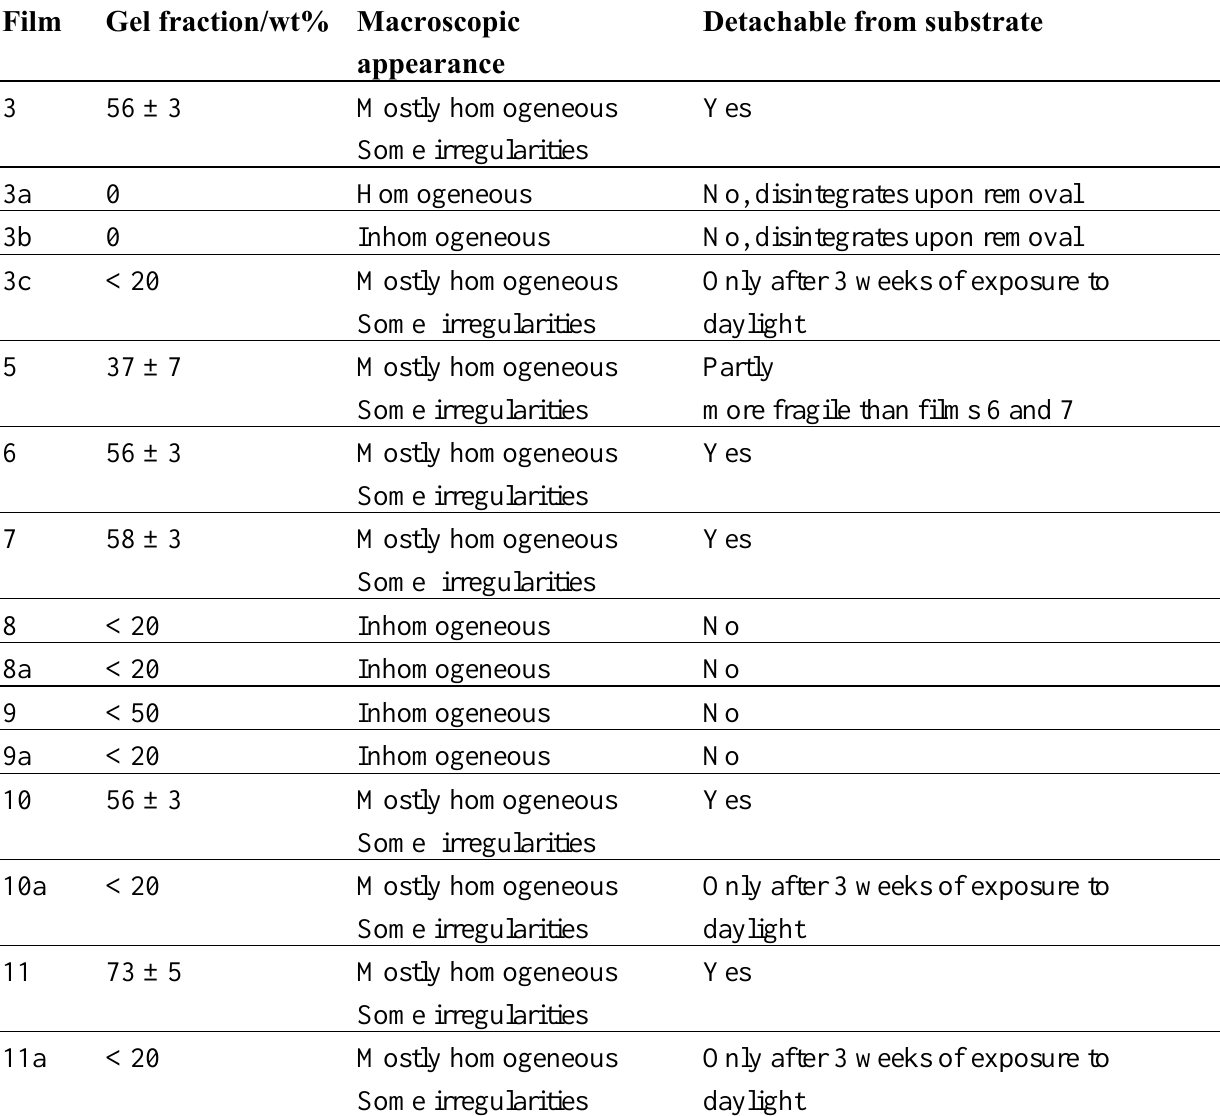
Table 2. Solubility, macroscopic appearance, and detachability of the films listed in Table